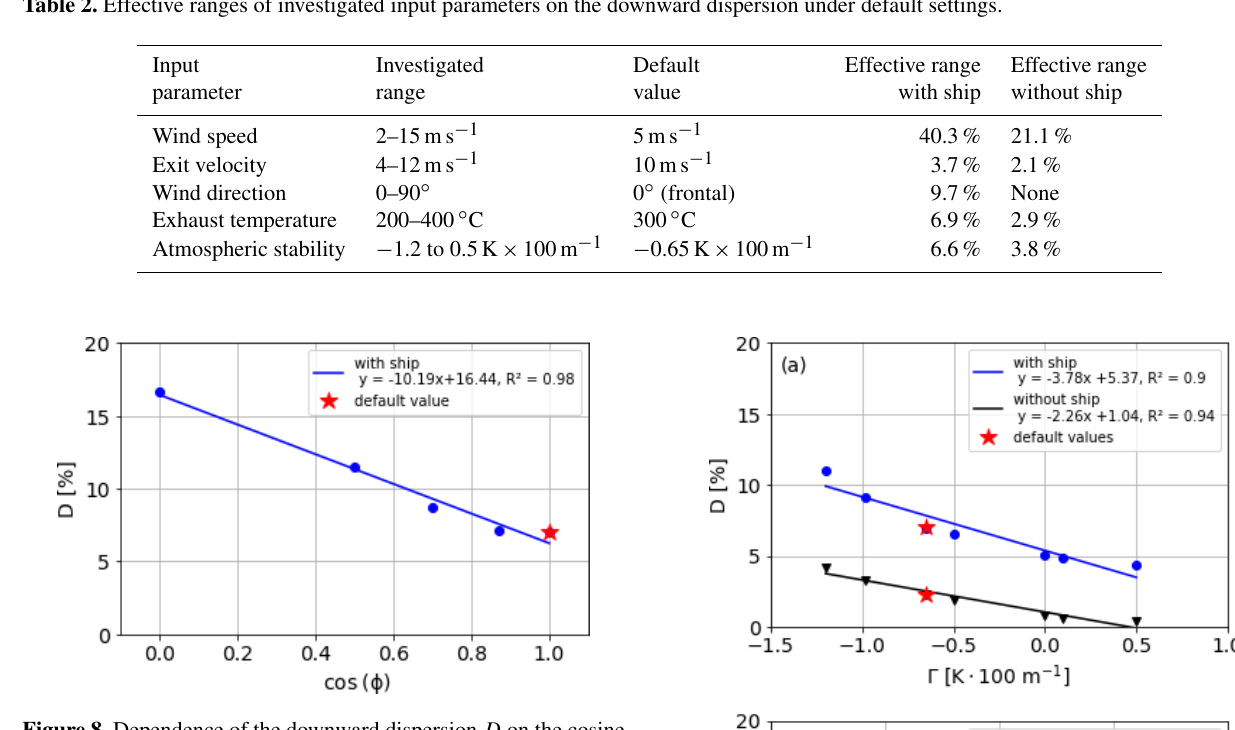
Figure 8. Dependence of the downward dispersion D on the cosine of different wind flow angles ( φ ) towards the ship. An angle of 0 ◦ indicates the frontal wind; 90 ◦ indicates the lateral wind.